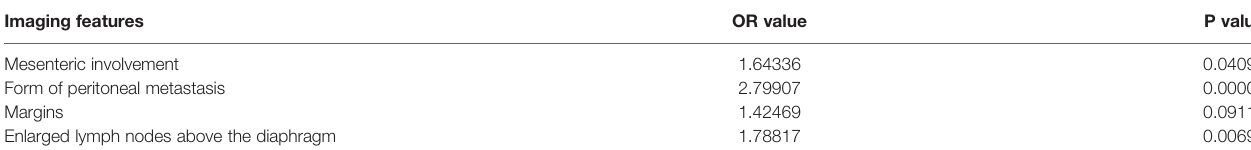
TABLE 3 | Single-factor logistic regression analysis of correlation between CT features and BRCA mutation status.